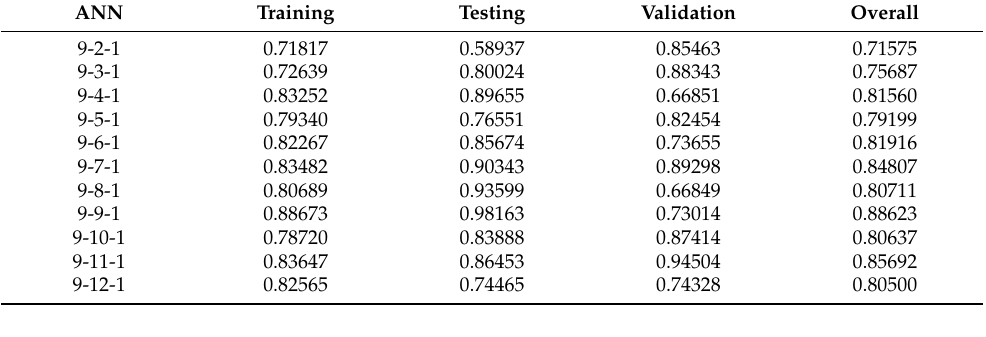
Table 2. Tried ANN architectures.